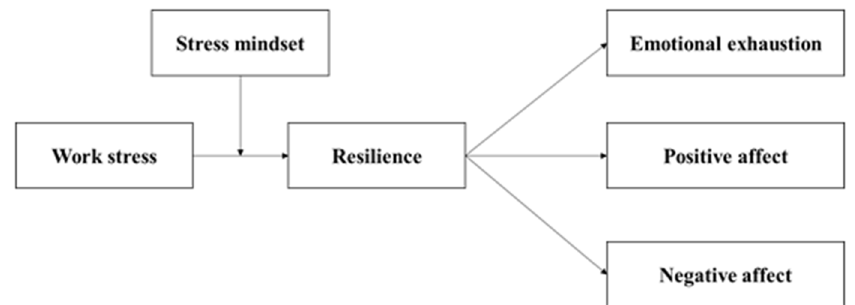
Figure 1. Theoretical model of this study.